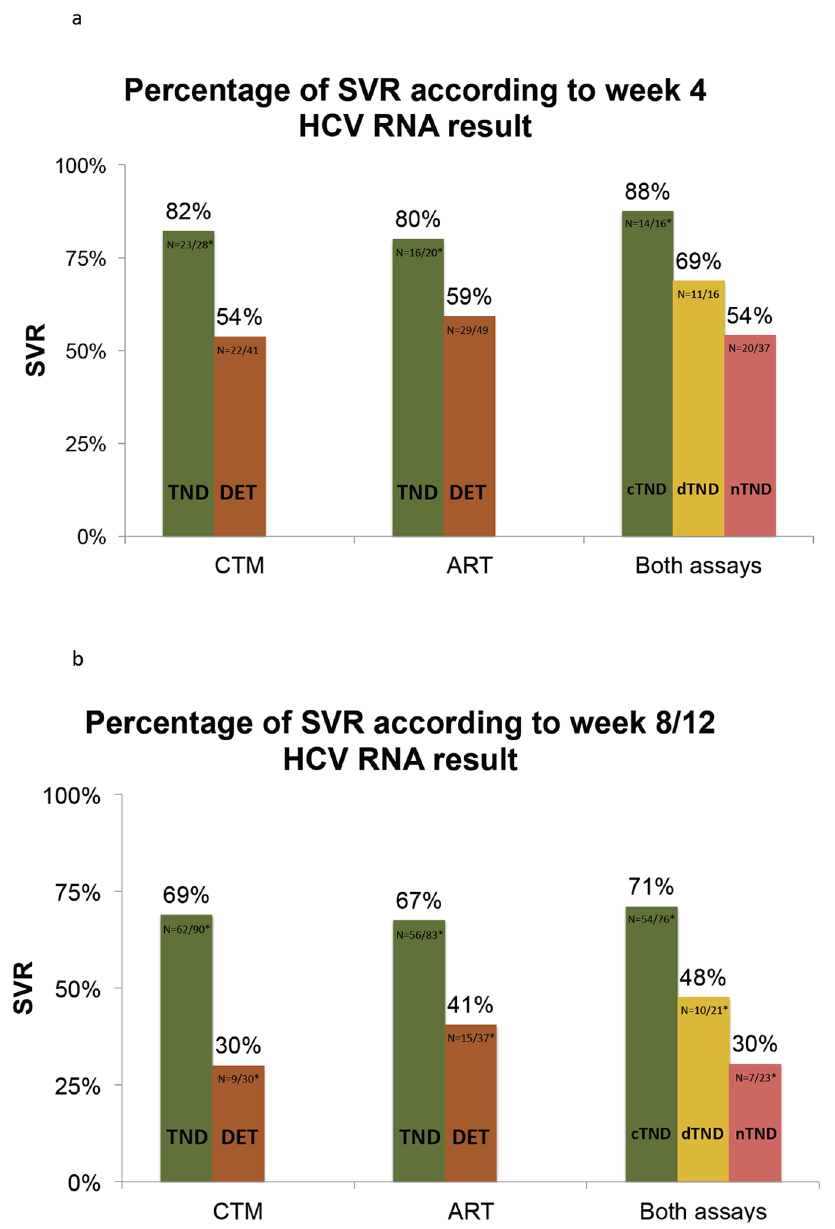
Figure 1. Predictive value of HCV RNA results in the CTM and ART at week 4 (a) and week 8/12 (b) after start of therapy with a protease inhibitor. TND = target not detected; DET = HCV RNA detected; TND/TND = HCV not detected in both assays; TND/DET = HCV RNA detected by only one assay; DET/DET: HCV RNA detected by both assays. *Patients with unavailable virological treatment outcome were excluded from analysis.